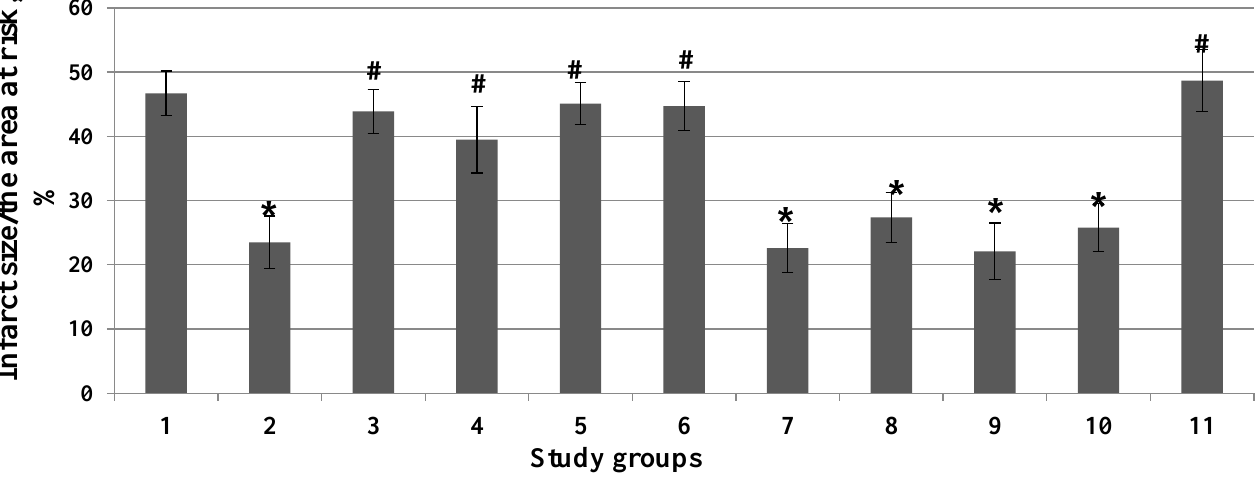
Figure 3. Involvement of kinases and NOS in the infarct-limiting effect of deltorphin II ( Y -axis). 1—Control; 2—Deltorphin II; 3—Deltorphin II + Chelerythrine; 4—Deltorphin II + Rottlerin; 5—Deltorphin II + Wortmannin; 6—Deltorphin II + PD98059; 7—Deltorphin II + H-89; 8—Deltorphin ODQ. Data represent the means ± SEM. * p < 0.05 vs. the control group; # p < 0.05 vs. the deltorphin II group. Each study group included 12